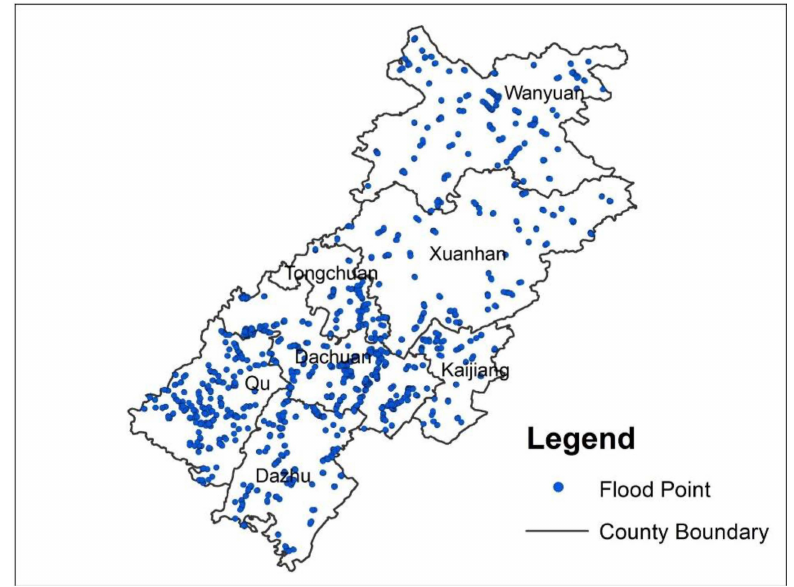
Figure 2. Distribution of historical flood points in Dazhou